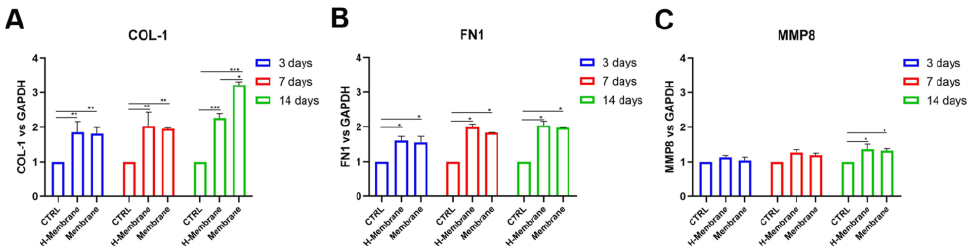
Figure 9. Real-time PCR of fibroblasts (HGFs) seeded on H-Membrane and Membrane for genes encoding Collagen 1 (COL1) ( A ), Fibronectin 1 (FN1) ( B ), Metalloprotease 8 ( C ) at 3, 7, and 14 days post-seeding (* p < 0.05; ** p < 0.001; *** p < 0.0001). The expression of COL-1, FN1, and MMP8 were upregulated in H-Membrane and Membrane with respect to CTRL.